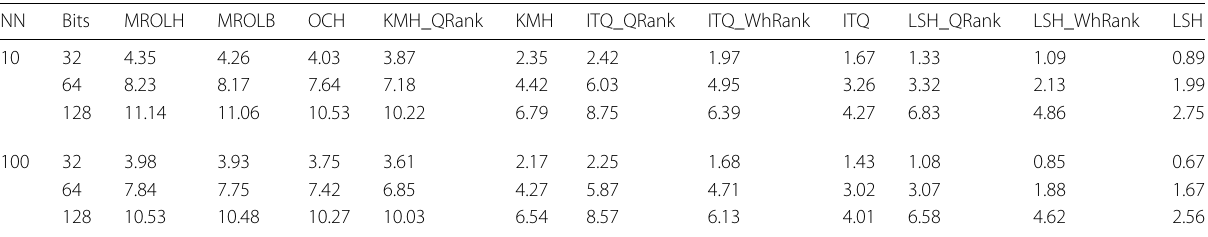
Table 2 The mAP ( % ) values of the comparative experimental results in the GIST1M dataset NN